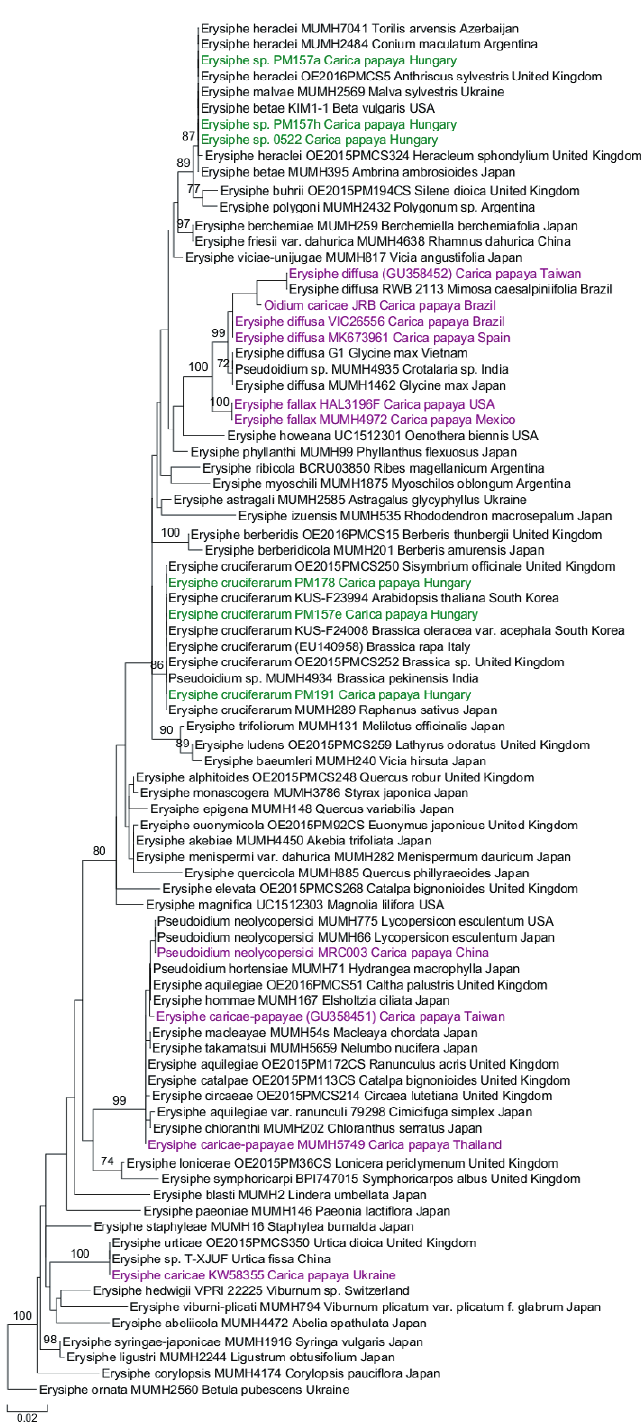
Figure 3. Phylogenetic tree with the greatest likelihood value resulting from the maximum likelihood (ML) analysis of ITS sequences of selected powdery mildew species belonging to the Microsphaera lineage of Erysiphe . Species names are followed by herbarium accession numbers (or GenBank accession numbers in parentheses if the herbarium accession number is not available), name of host plant, and coun- try of collection. Samples collected in the present study are in green font, while other powdery mildew samples from papaya are in purple. Bootstrap values were calculated from 1000 replicates in the ML analysis (values below 70% and in subclades are not shown). Bar indicates 0.02 expected changes per site per